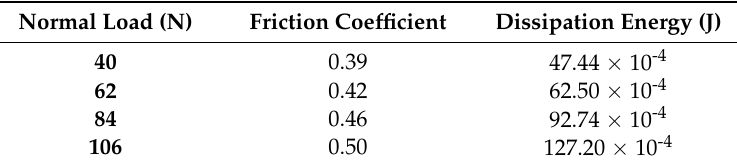
Table 3. Dissipated energy with the increasing normal